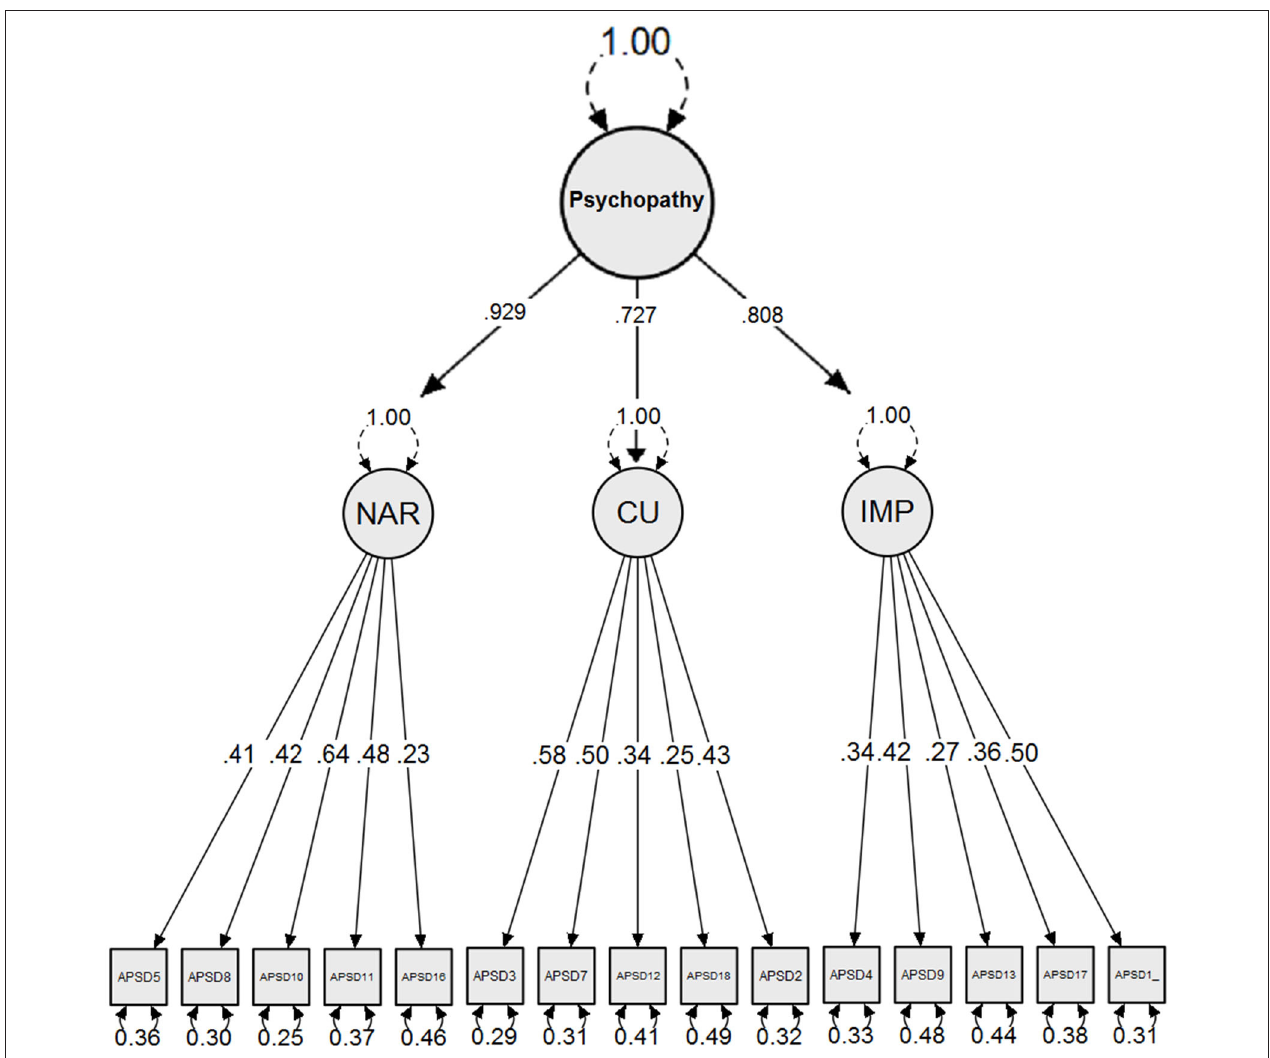
FIGURE 1 | Confirmatory factor analysis model ( n = 675). NAR, Narcissism; CU, Callous-Unemotional; IMP,